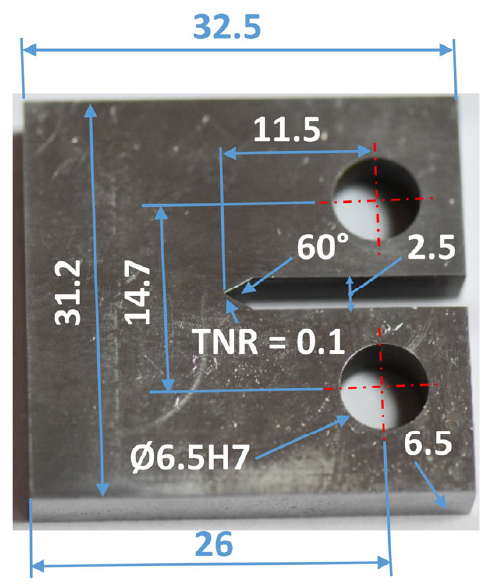
Figure 1. CT mini ‐ specimens used in the fracture toughness tests of the MMC. Figure 1. CT mini-specimens used in the fracture toughness tests of the